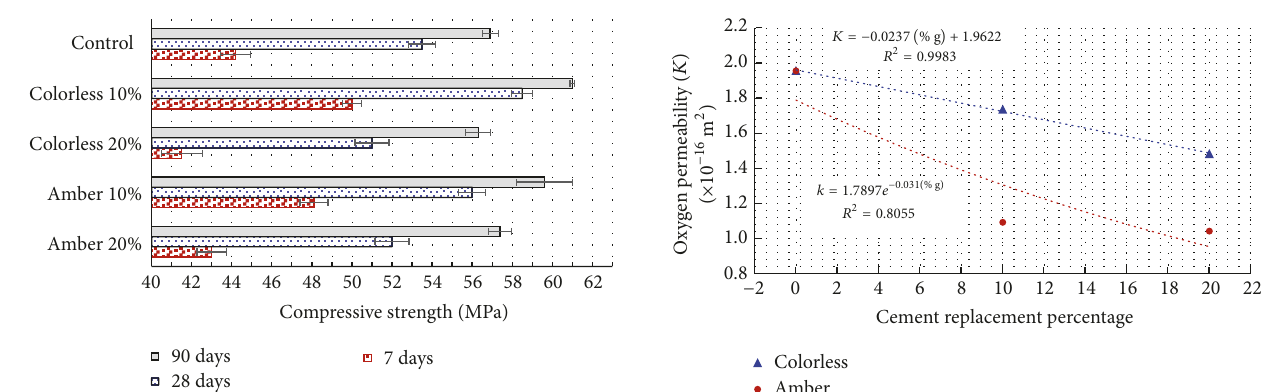
Figure 2: Results of oxygen permeability test after 60 days of